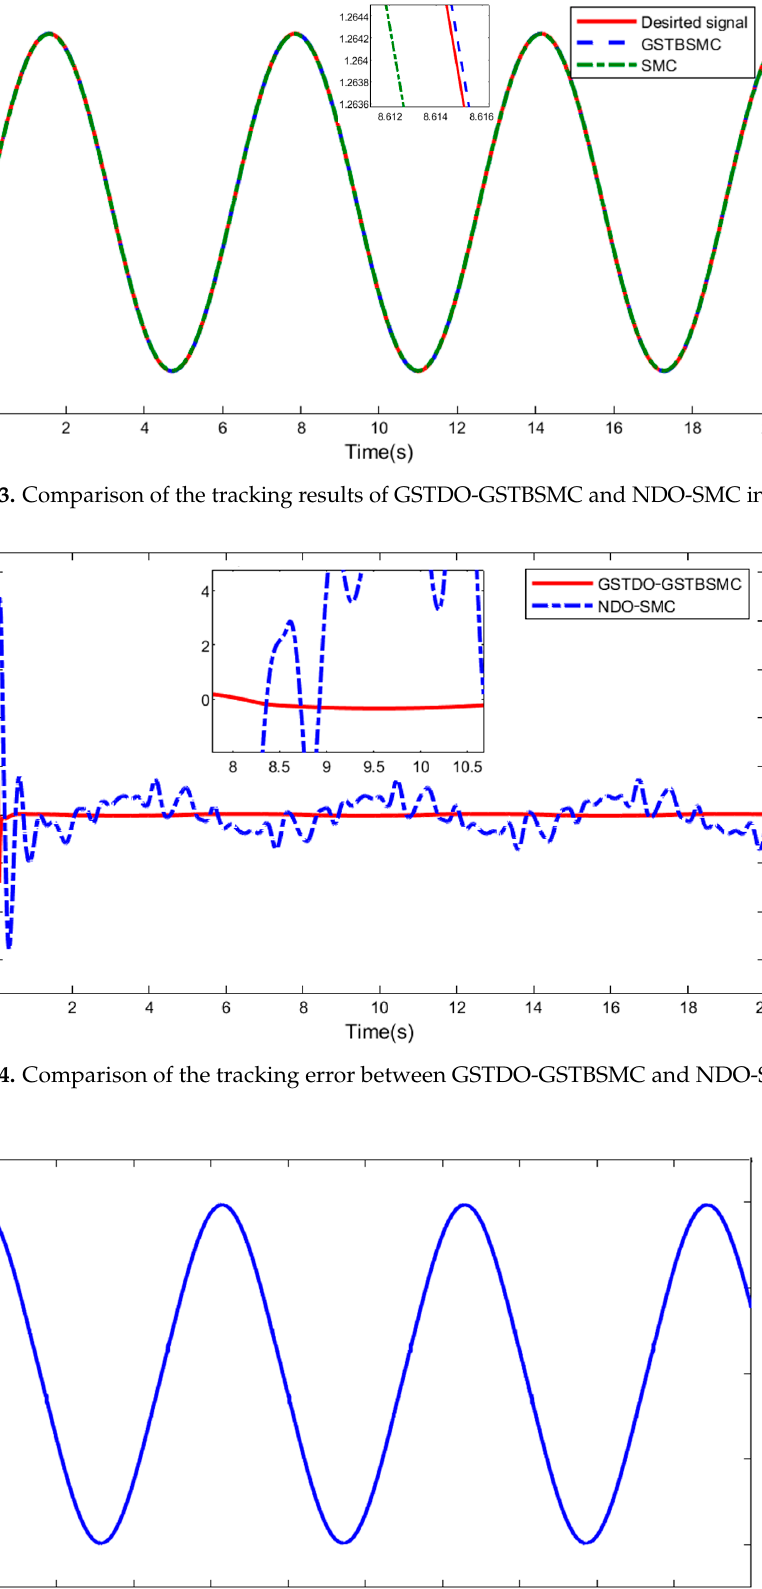
10 of 22 Table 1. System Parameters. Parameters